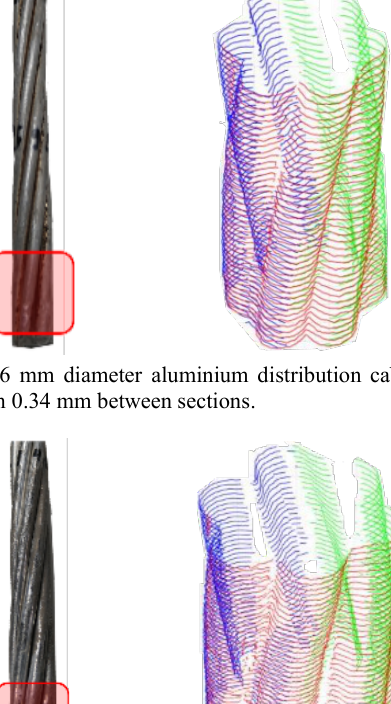
Figure 11: 1” deformed PVC pipe – 26 measured sections with 0.68 mm displacement between sections.